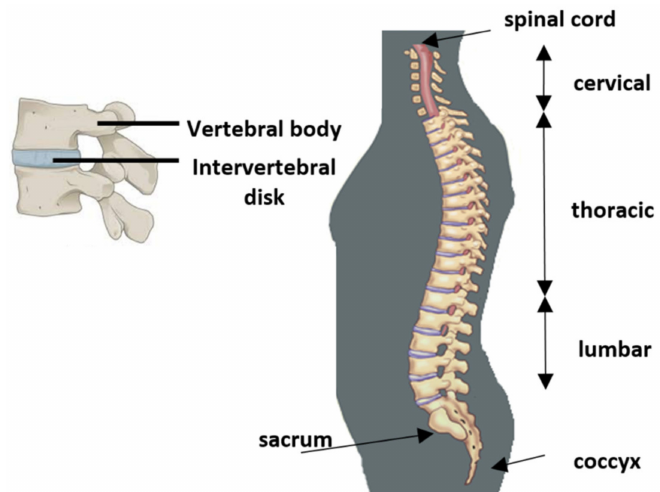
Figure 1. Basic spinal